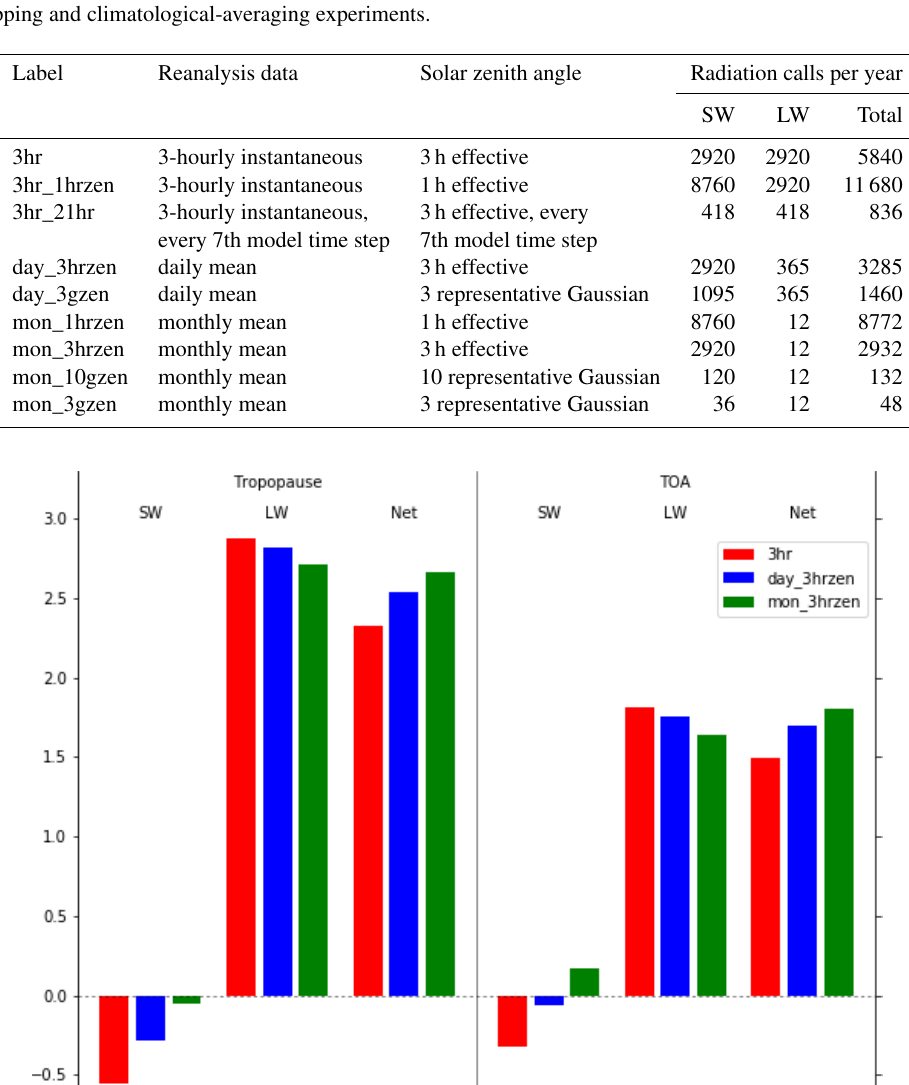
Table 3. Time-stepping and climatological-averaging experiments. Label